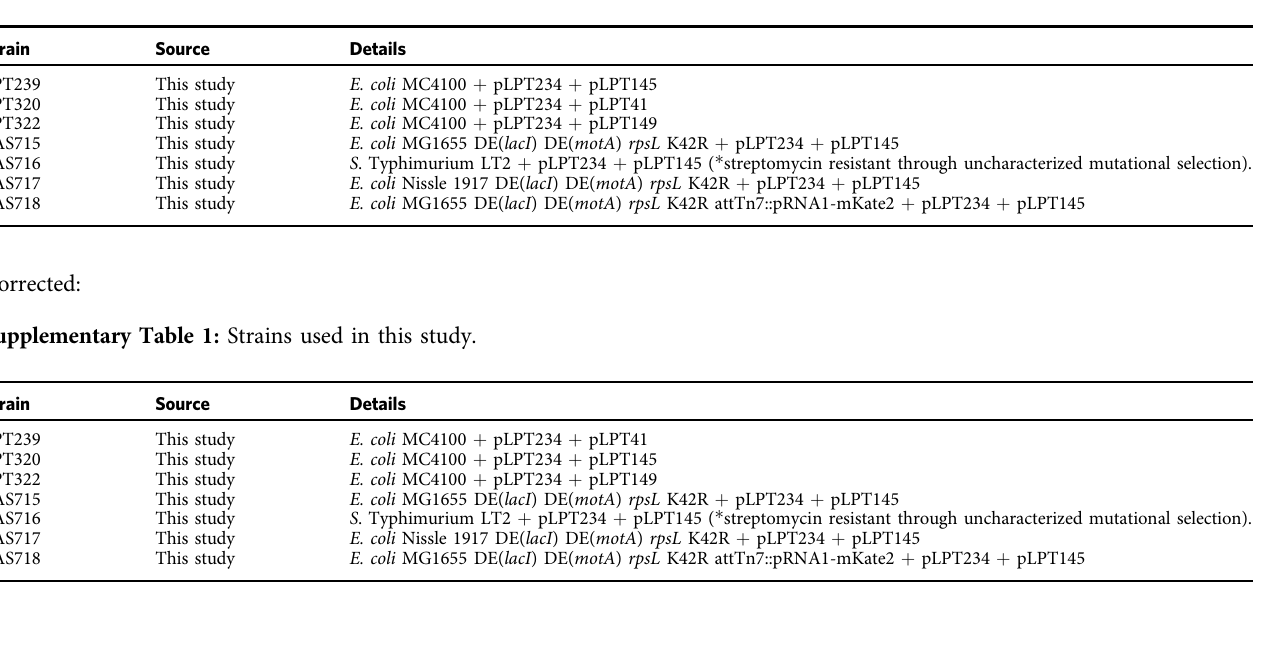
Supplementary Table 1: Strains used in this study.